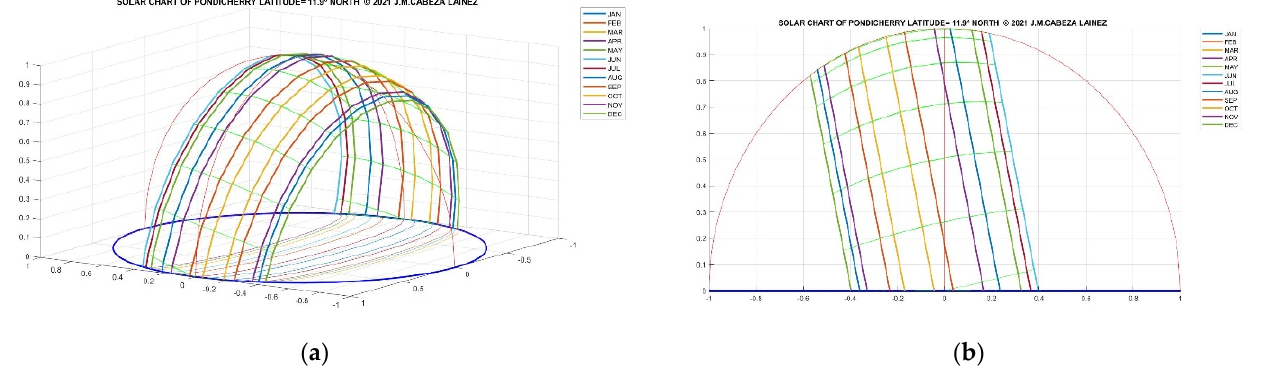
Figure 9. Simulations of the solar movement in Pondicherry (India) created by the authors: ( a ) 3- dimensional movement; ( b ) elevation movement. ( a ) 3-dimensional movement; ( b ) elevation